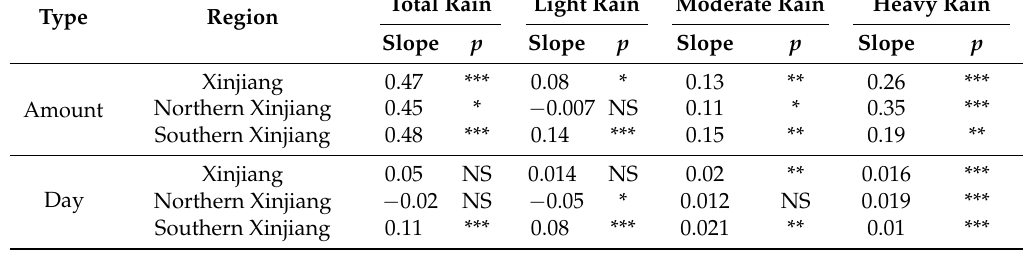
Table 1. Trends in rain amounts (mm/year) and days (day/year) for Xinjiang, northern Xinjiang, and southern Xinjiang during the warm season from 1960–2014. “Slope” and “ p ” indicate the slope and the statistical p value, respectively. The symbols *, **, and *** represent significance at the 0.05, 0.01, and 0.001 levels, respectively. NS indicates “not significant”.